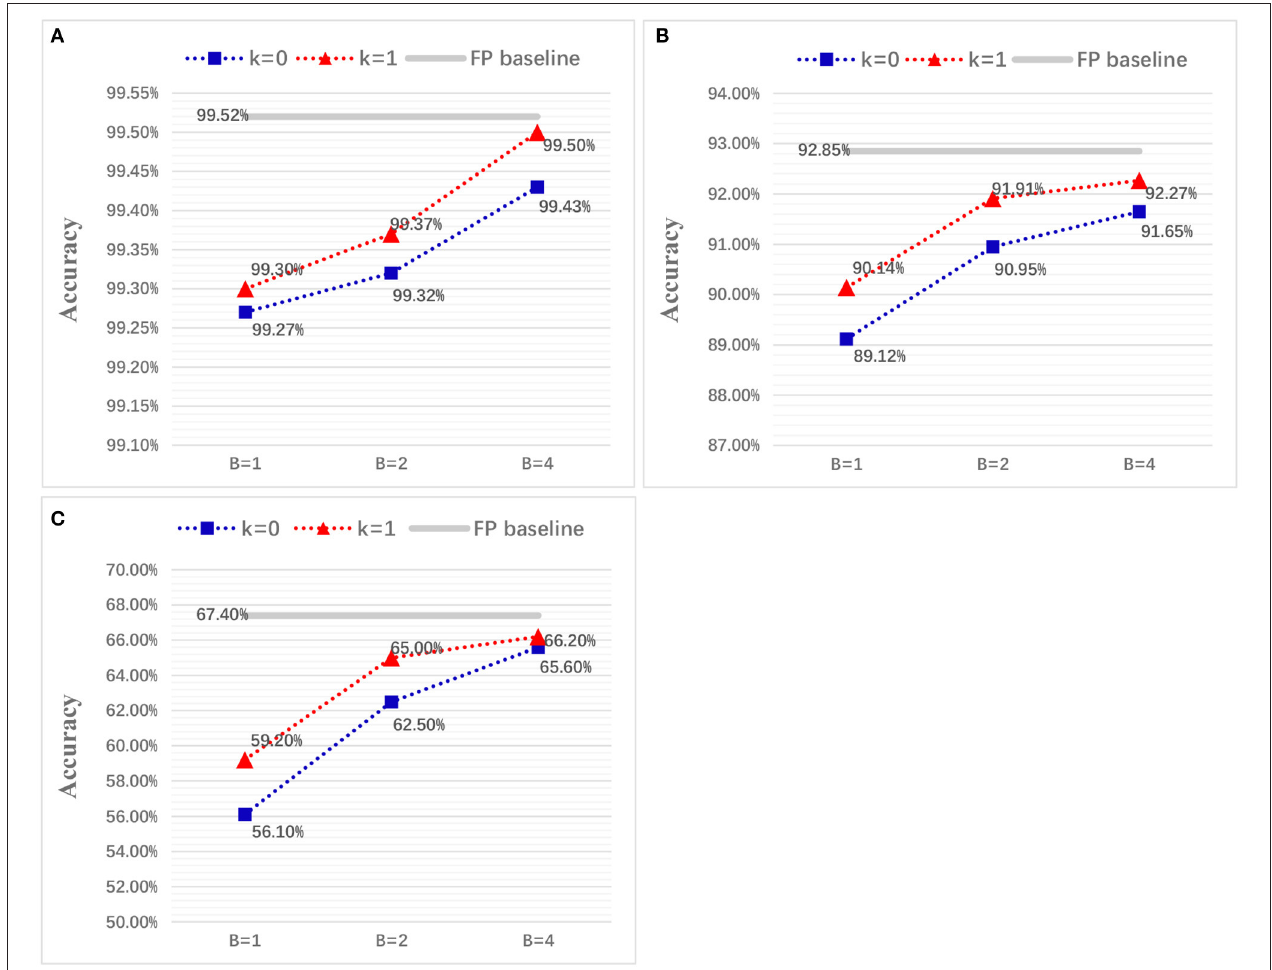
FIGURE 9 | Classification accuracy for LeNet on MNIST (A) and VGG-Net on CIFAR-10/100 dataset (B,C) , with different quantization